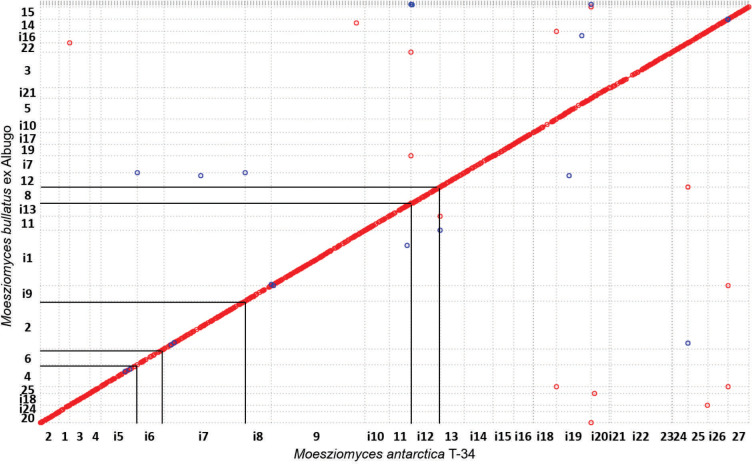
Genome comparison of MbA and Moesziomyces antarctica T-34.Highlighted regions show that contigs with chromosomal rearrangements in MBA can be also found in the genome of the related species Moesziomyces antarctica T-34.